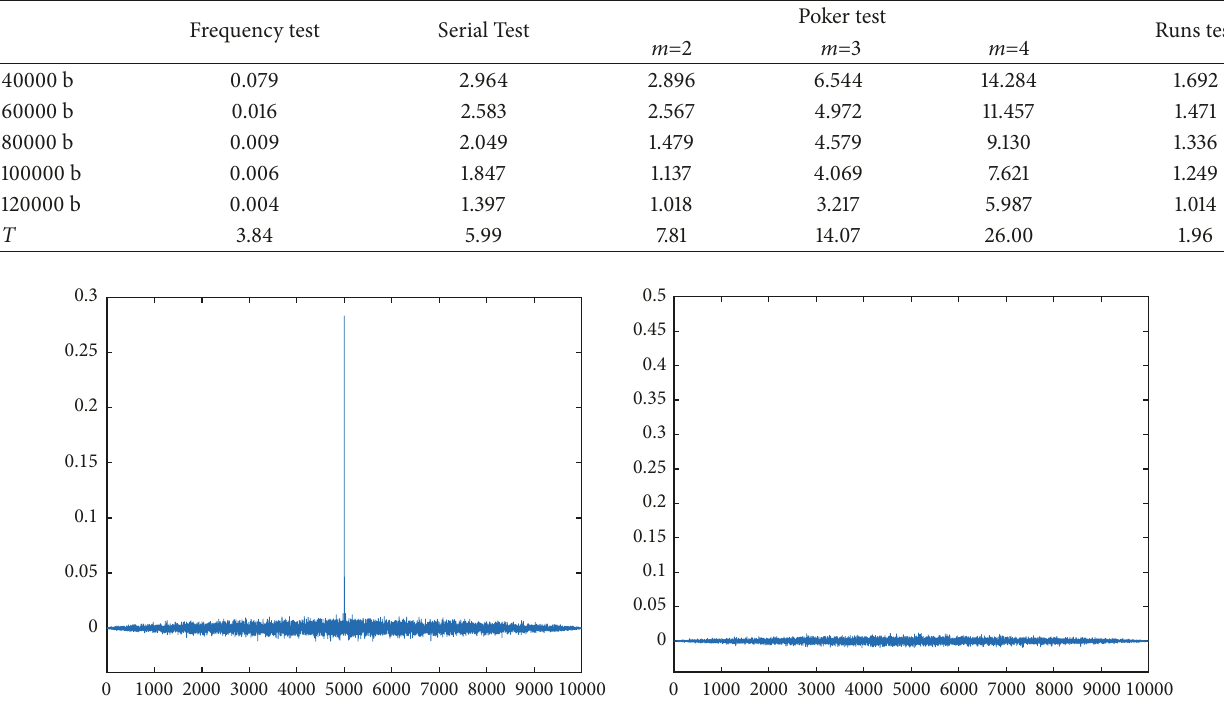
Figure 7: Correlation tests of